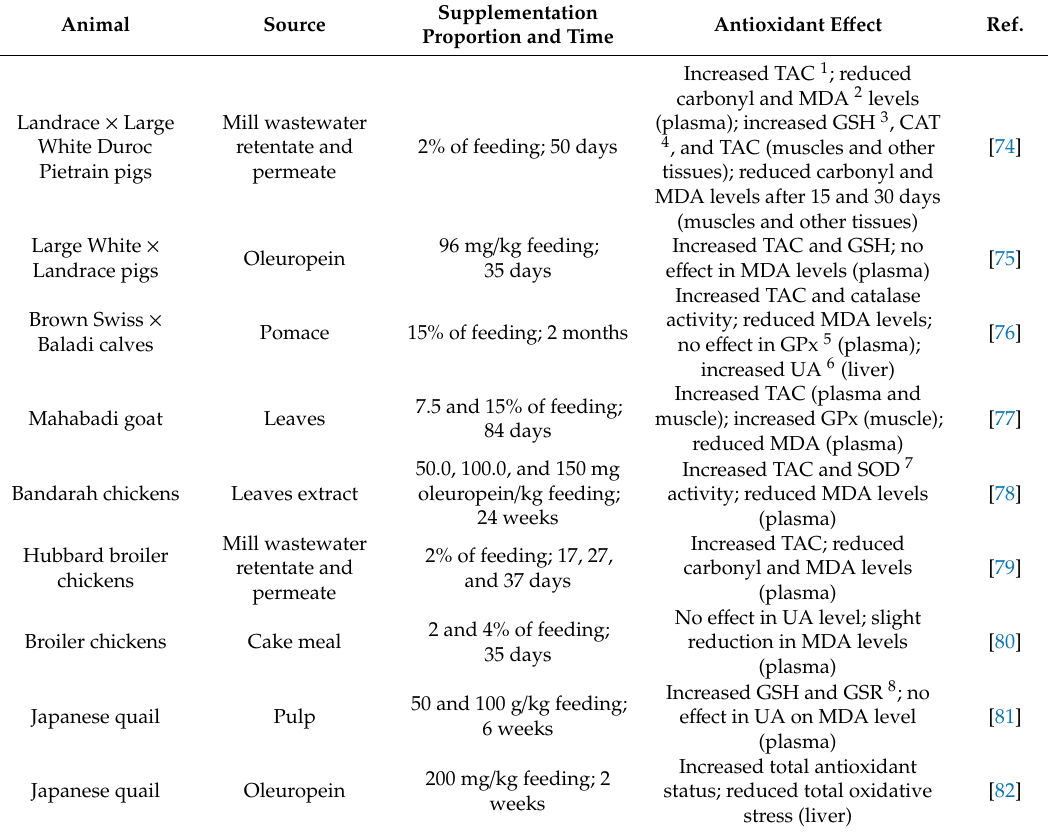
Table 3. Antioxidant activity in vivo of meat-producing animals fed with Olea europaea polyphenols. Supplementation Antioxidant E ff ect Ref. Animal Source Proportion and Time